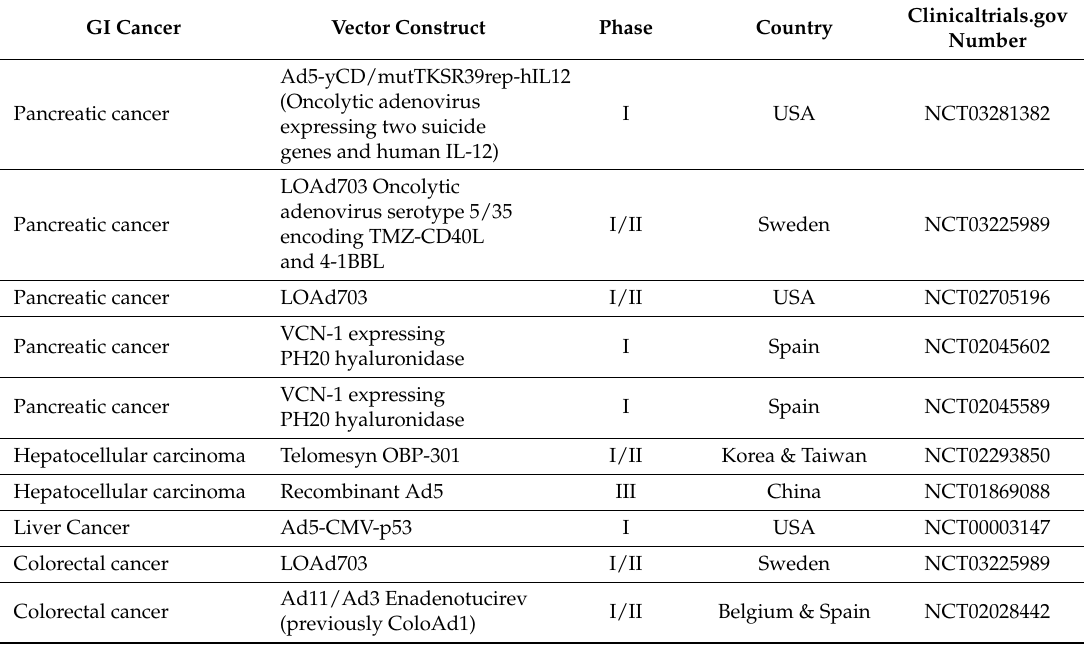
Table 8. Clinical trials using adenoviral oncolytic therapy in gastrointestinal